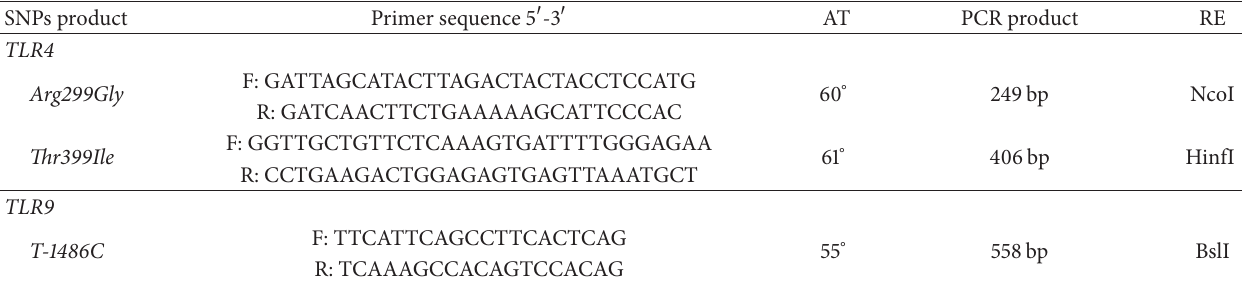
Table 1: Primers, PCR conditions, and restriction enzymes used for genotyping TLRs genes.